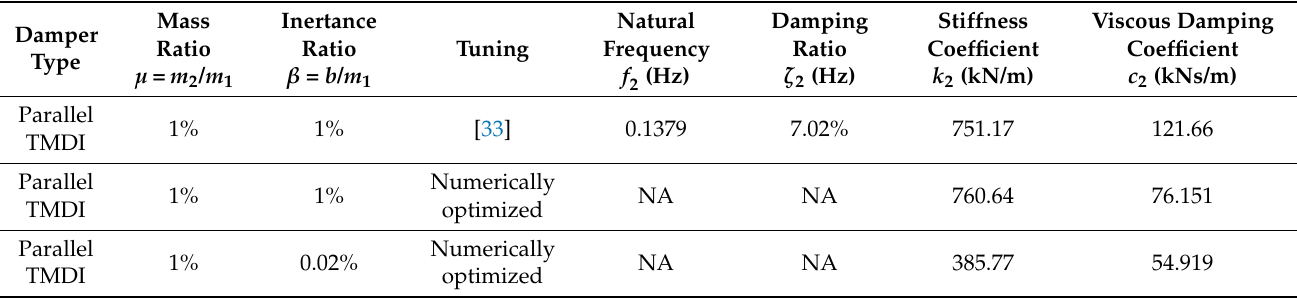
Table 3. Parameters of TMDIs with an inerter in parallel to stiffness and viscous